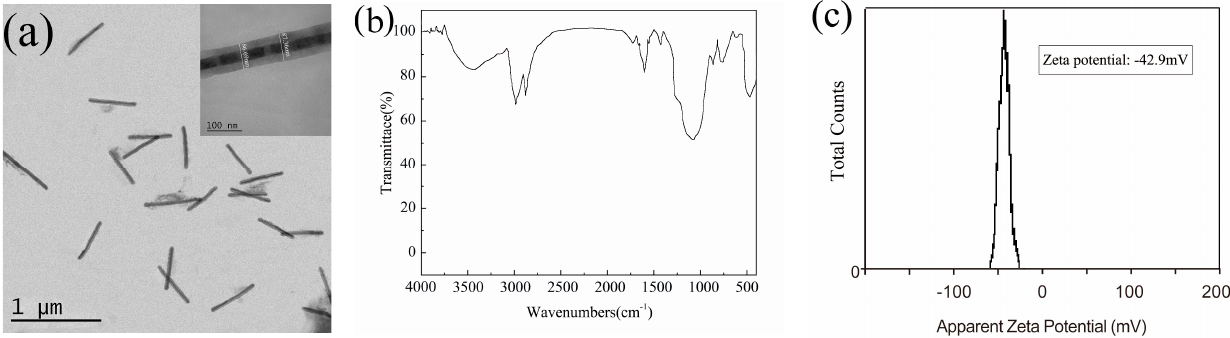
Figure 5. ( a ) TEM image of 4# Fe/Mn@SiO 2 NWs; the inset shows an individual NW enlarged; ( b ) FT-IR spectra; ( c ) zeta potential.